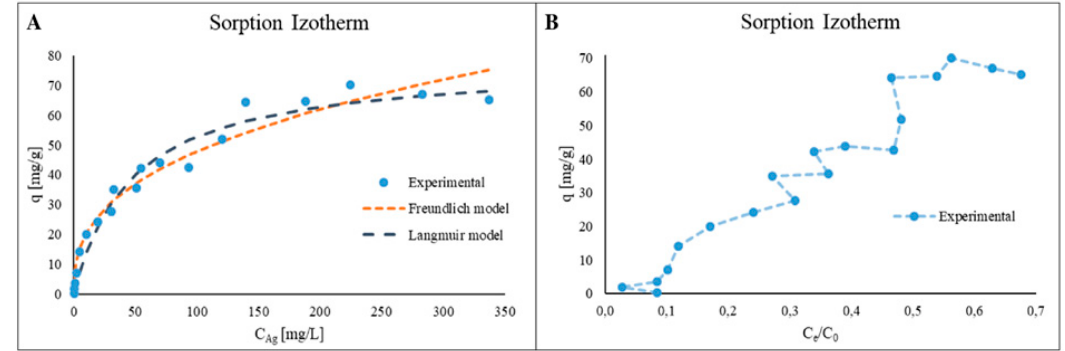
Figure 2. Isotherm of Ag + ions sorption onto casein and fitting of the Freundlich and Langmuir isotherms models ( A ); sorption isotherm of Ag + ions as a function of C e / C 0 ( B ).